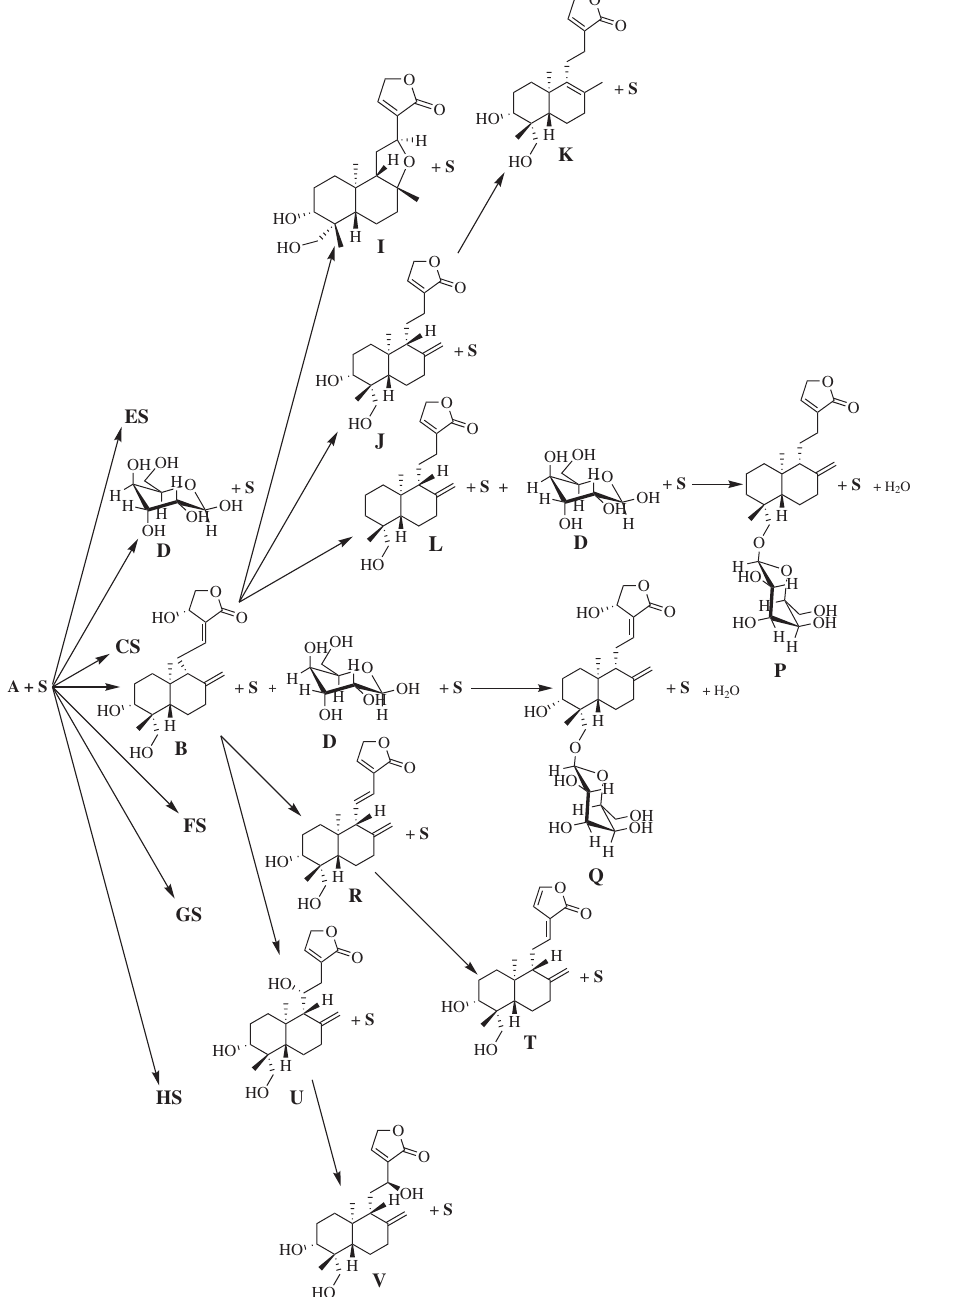
Figure 4: Multiple competing green solid-liquid extractions in series with multiple reactions of andrographolide (desired product extract) from Andrographis paniculata (AP) and other phytochemical compounds (undesired products) in parallel and